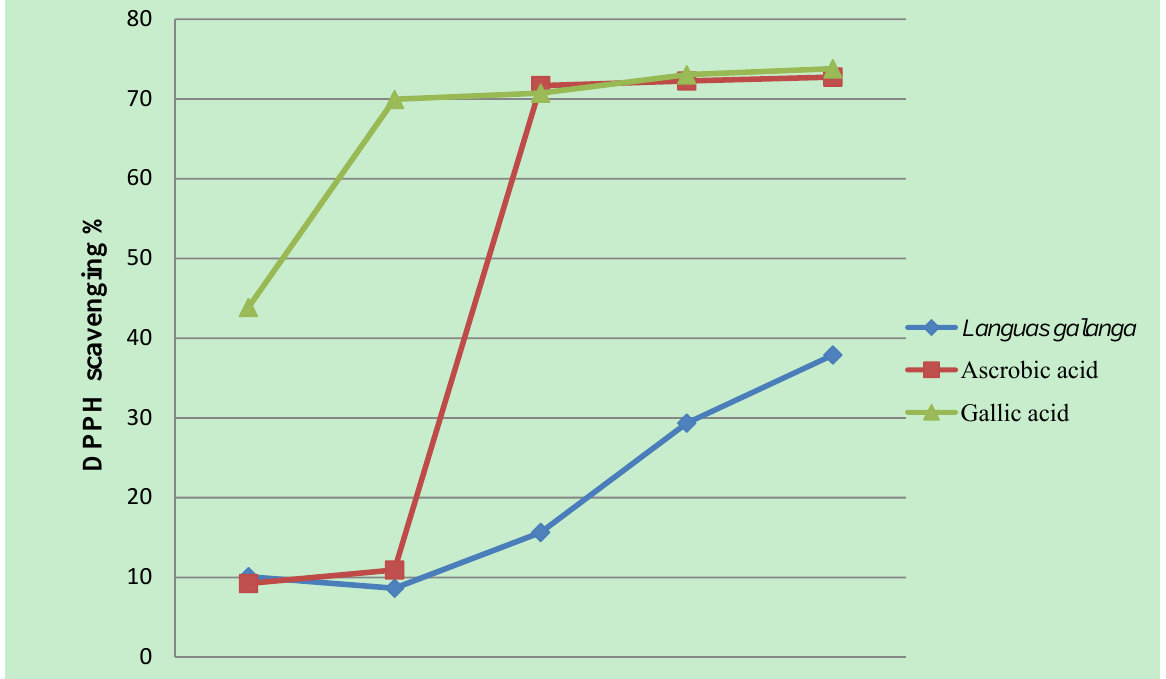
Figure 1. DPPH radical scavenging activities of the methanolic extract of Languas galanga rhizomes, ascorbic acid and gallic acid at different concentrations of µg/mL. Absorbance values represent means of triplicates of different concentrations